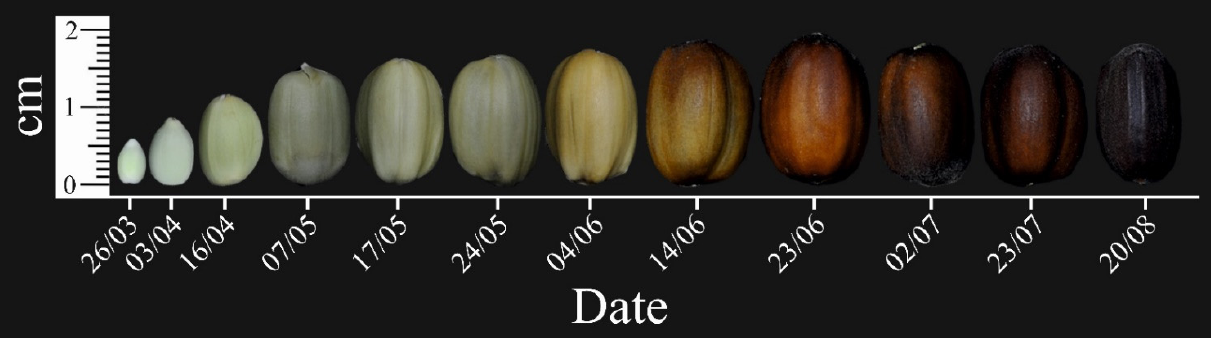
Figure 3. Benzioni seed development scale in 2018.